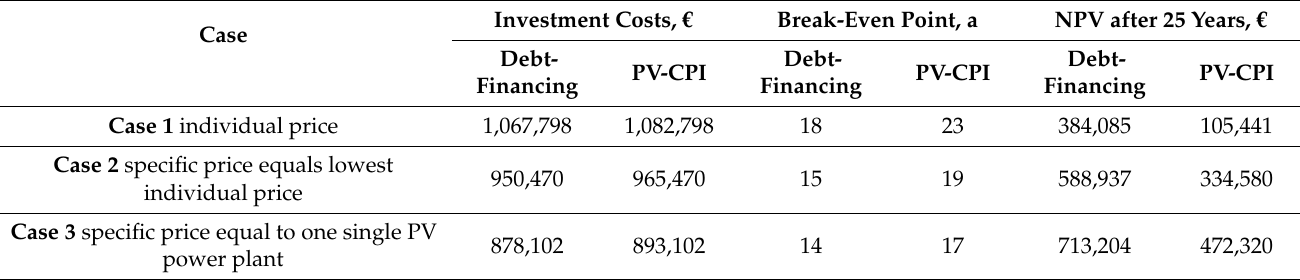
Table 5. Summary of investment costs, net present value (NPV), and break-even point after the useful lifetime.